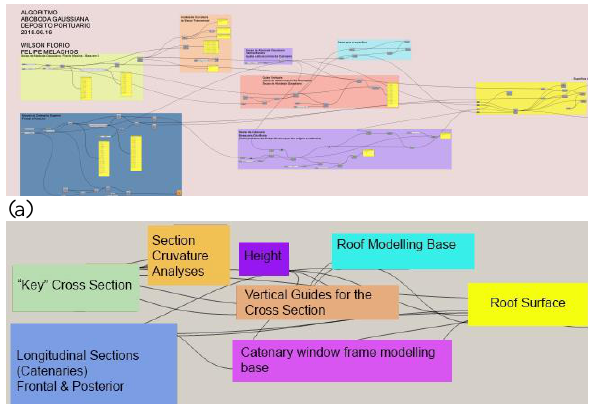
Figure 8: The Grasshopper © script used in this research to model the Seaport of Montevideo’s Gaussian Vault roof surface. In (a) the components used are shown in their operating sequence and grouped by color as according to their functions. In (b), these groupings have their main output highlighted in order to further explain the outputs of each portion of the algorithm.